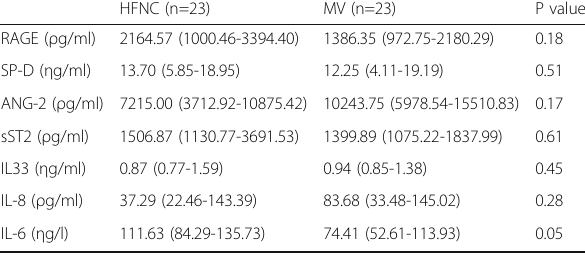
Table 110 (abstract A339). Biomarkers at day 1 (median